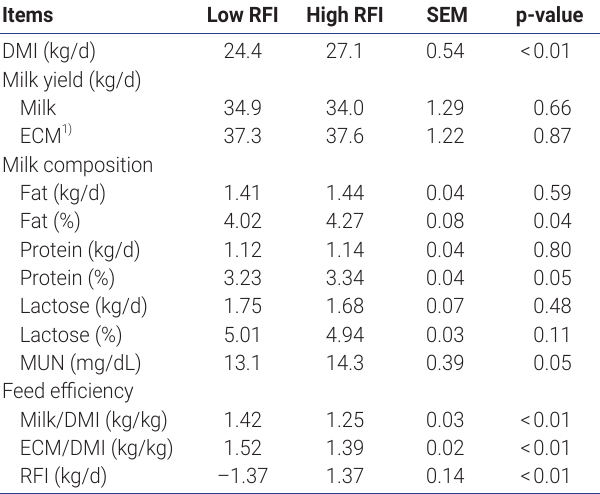
Table 2. Milk production and feed efficiency in lactating cows select - ed for phenotypic divergence in residual feed intake